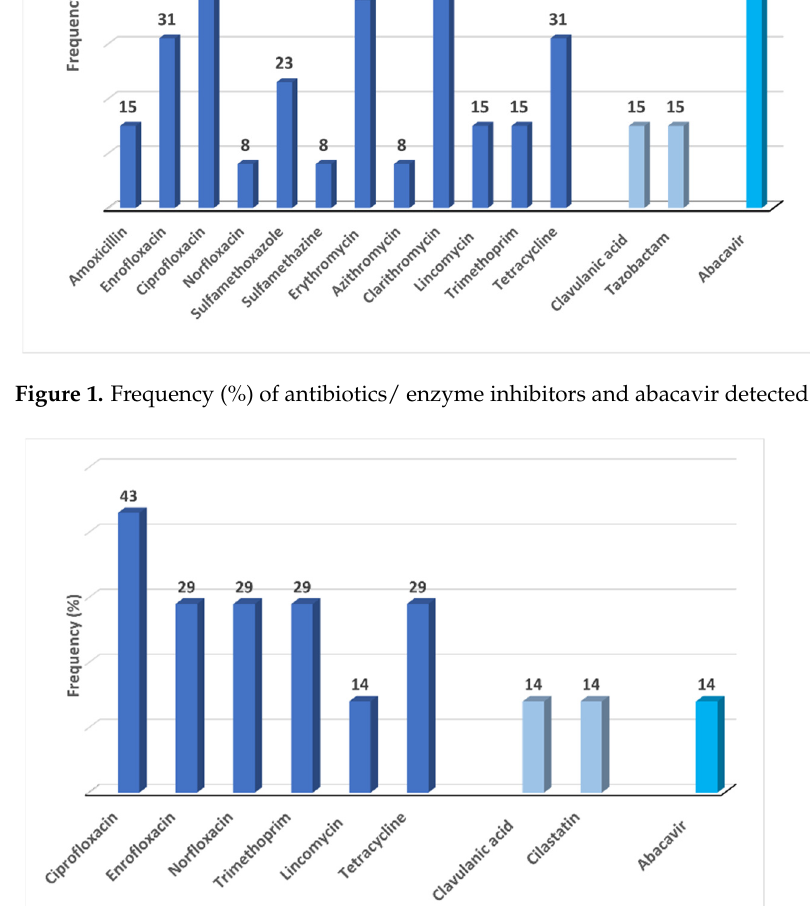
Figure 1. Frequency (%) of antibiotics/ enzyme inhibitors and abacavir detected in surface water.